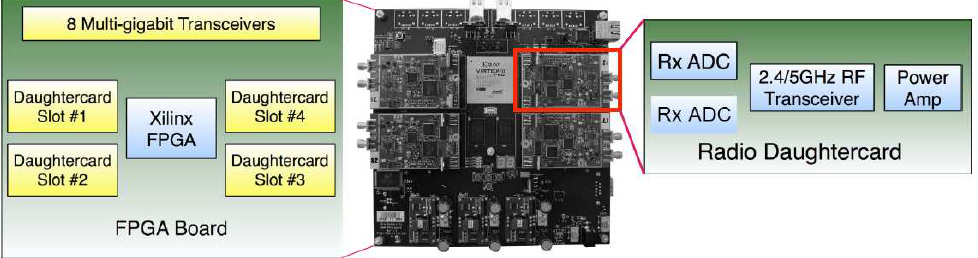
Figure 17. WARP custom hardware, including the Virtex-II Pro FPGA board and radio